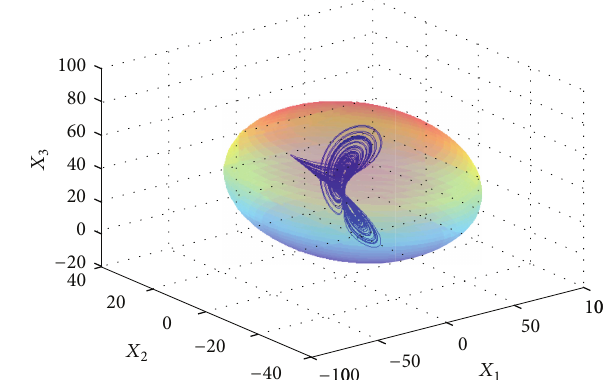
Figure 2: The chaotic attractor of system (1) with 𝑎 = 25 , 𝑏 = 16 , 𝑐 = 40 , 𝑑 = 4 , 𝑒 = 5 , 𝑓 = 4 , and 𝑔 = 1.5 and its analytic ellipsoidal ultimate boundary